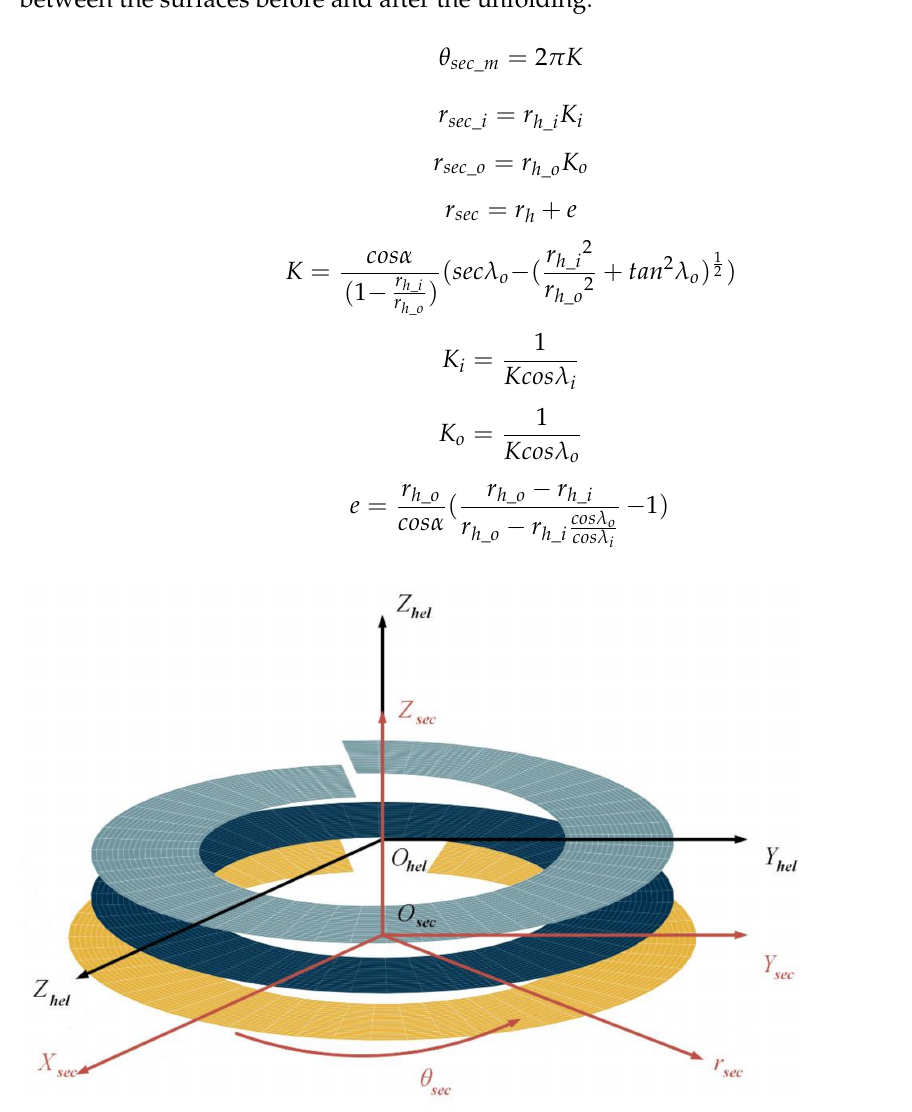
Figure 1. Diagrammatic diagram of the equivalent relation between the helicoid in a pitch and the annulus-sector